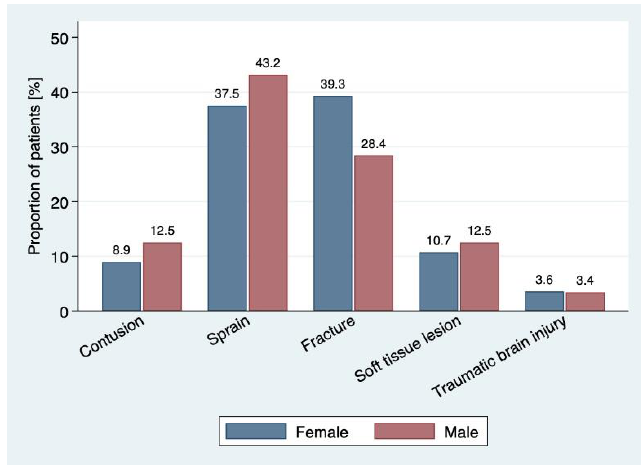
Figure 2. Distribution of different types of injuries.